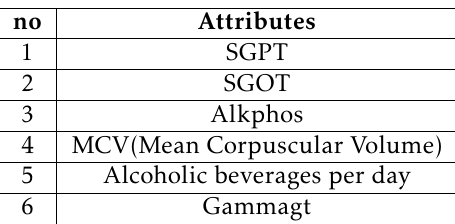
Table 2. The attributes of liver patients in BUPA